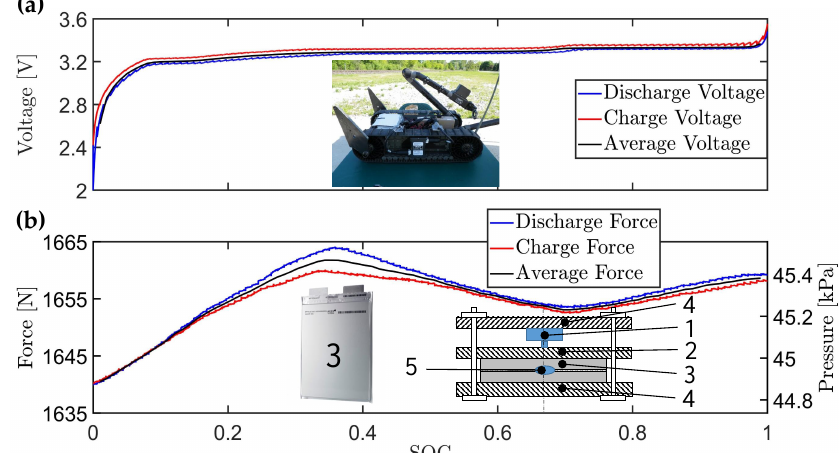
Figure 1. Measured voltage and force for the 20 Ah A123 lithium ion iron phosphate battery cycled under low current rate C /20. ( a ) Measured discharge (blue), charge (red), and average of discharge and charge (black) voltage for a C /20 cycle. For military robots such as the Packbot shown above, SOC estimation is critical to avoid the robot getting stranded. Lithium ion iron phosphate (LFP) batteries are typically used for operation of this robot due to the high power required. ( b ) Measured discharge (blue), charge (red), and average of discharge and charge (black) force for the under current rate C /20. The experimental battery fixture consists of: (1) load cell (force sensor); (2) movable plate; (3) lithium ion battery; (4) two aluminum end-plates; (5) temperature sensor. For generalization of the results to the other cell sizes, the force measurements can be converted to pressure by diving the force by the surface area of our battery ( A b ) , which is the width ( w b = 0.161 m) times the length ( l b = 0.227 m) of the battery, A b = w b × l b m 2